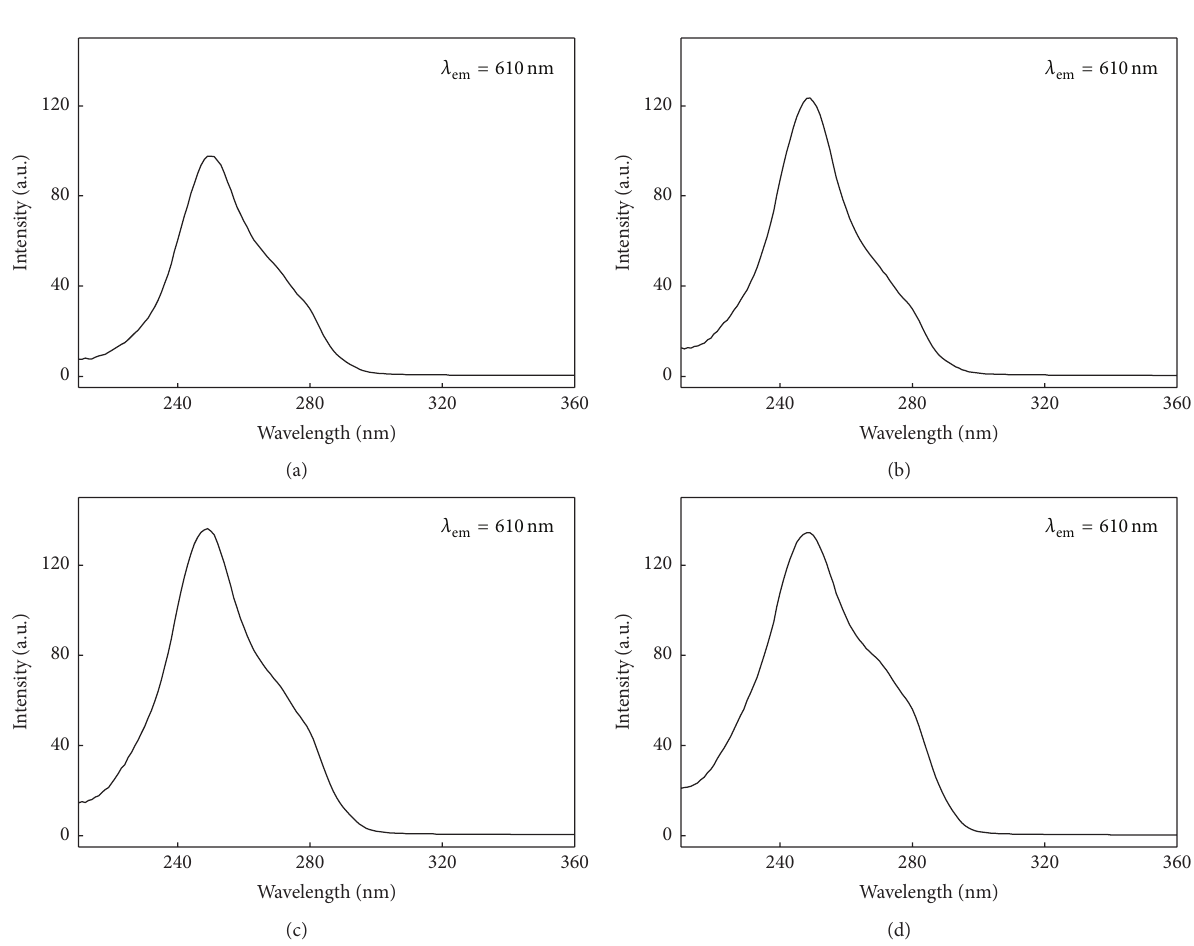
Figure 8: Excitation spectra of (a) 0.2 wt% EBA, (b) 0.4 wt% TBA-0.2 wt% EBA, (c) 0.8 wt% TBA-0.2 wt% EBA, and (d) 1.4wt% TBA-0.2 wt% EBA incorporated